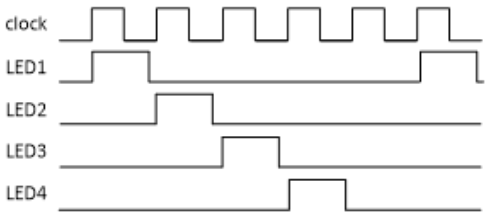
Figure 4. Timing diagram showing the order in which the LEDs are driven.